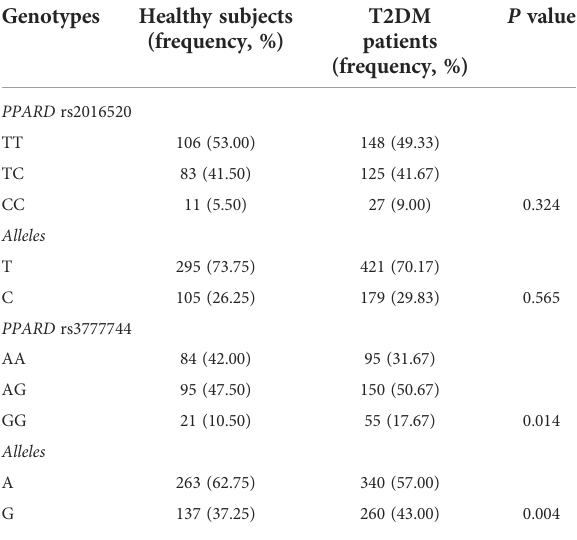
TABLE 1 Comparison of genotype and frequencies of PPARD variants between healthy controls (n = 200) and patients with type 2 diabetes mellitus (T2DM) (n =